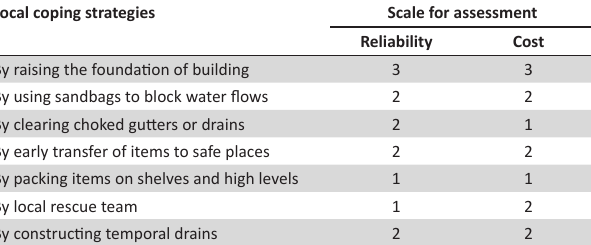
TABLE 2: Average results of reliability and cost of coping strategies: Households’ perspective. Local coping